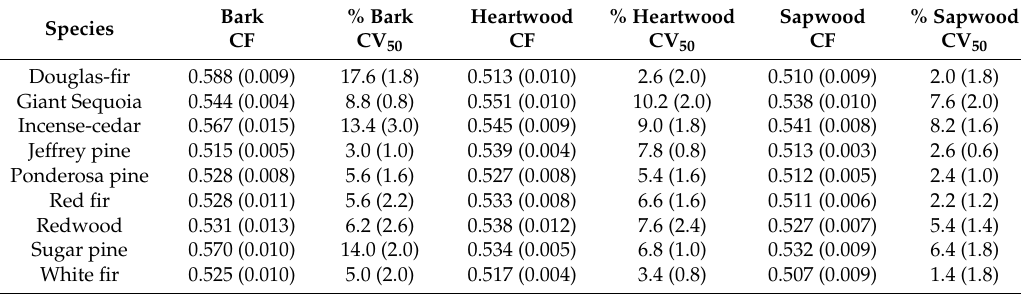
Table 2. Mean carbon fraction values, and coefficients of variation relative to an assumed carbon fraction of 0.5 (CV 50 ), for tissue types within nine conifer species. Standard deviations are shown in parenthesis after the mean carbon fraction and coefficient of variation